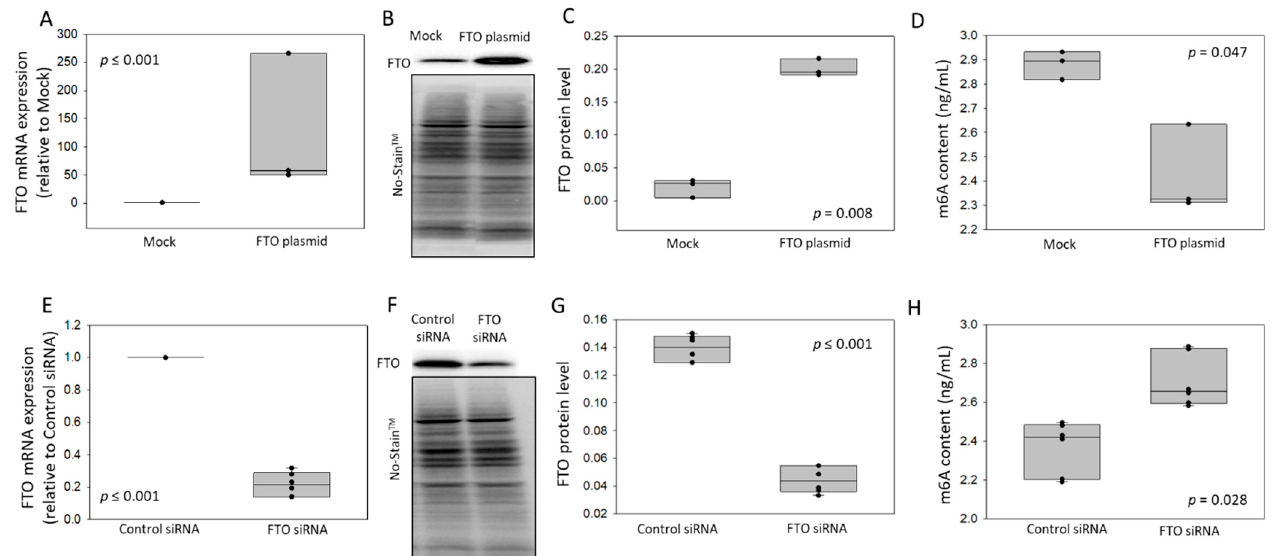
Figure 1. Gain- and loss-of-function experiments to validate m6A detection by LC-MS. SH-SY5Y cells were transfected for 48 h with a FTO over-expressing plasmid ( A – D ) or FTO siRNA ( E – H ).